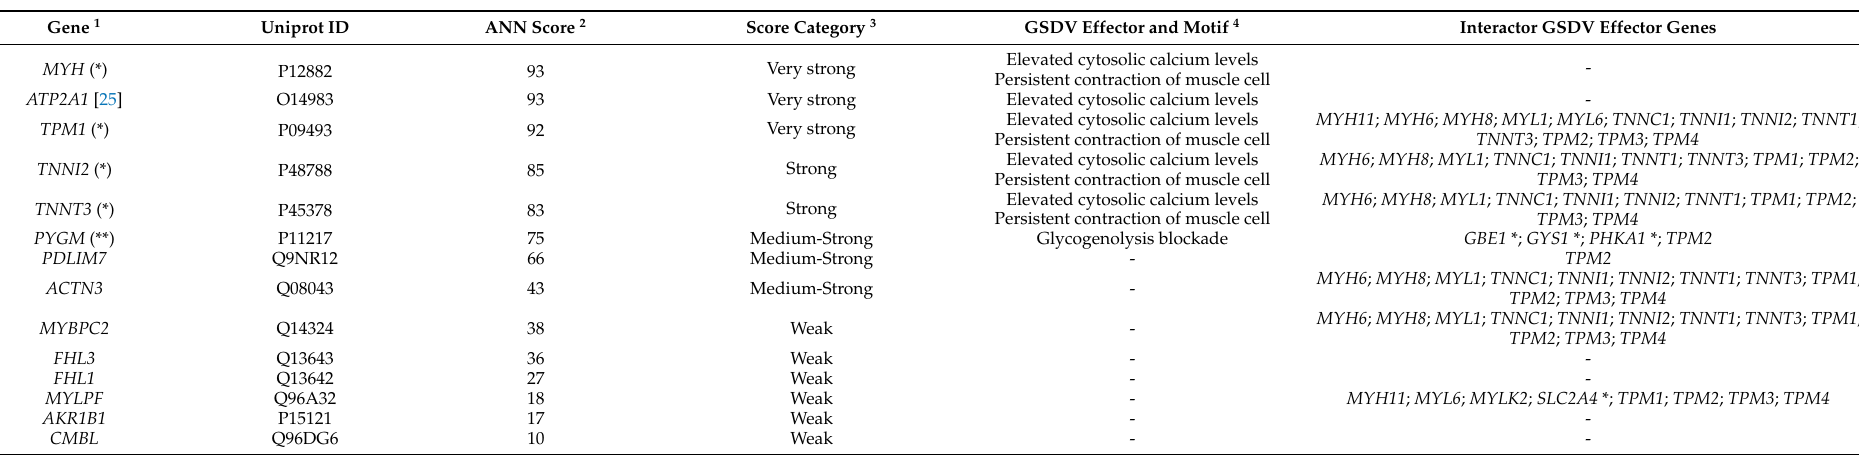
Table 5. Relationship between candidate proteins and GSDV described by molecular